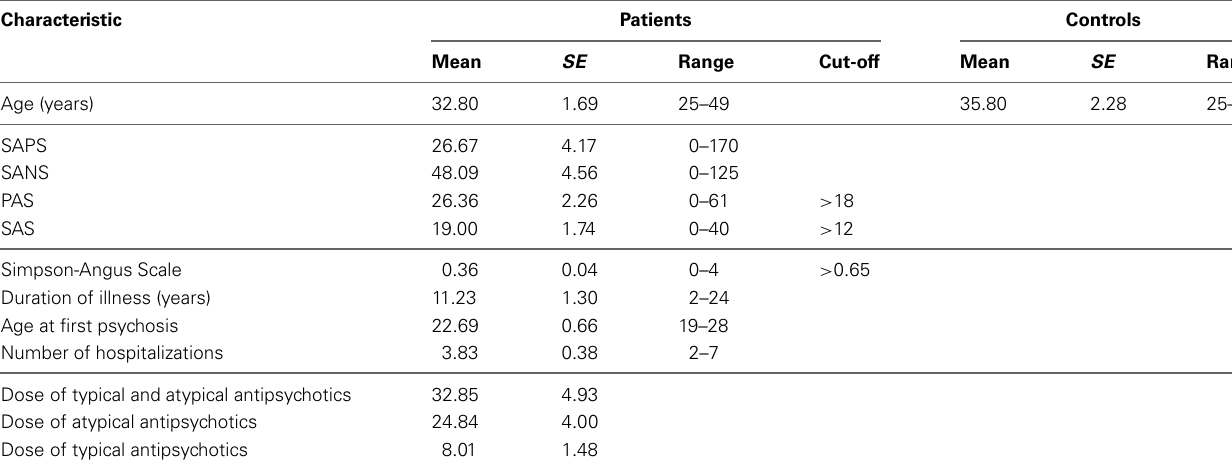
Table 1 | Demographic variables and characteristics of Schizophrenia (SZP) and Control (CNT)